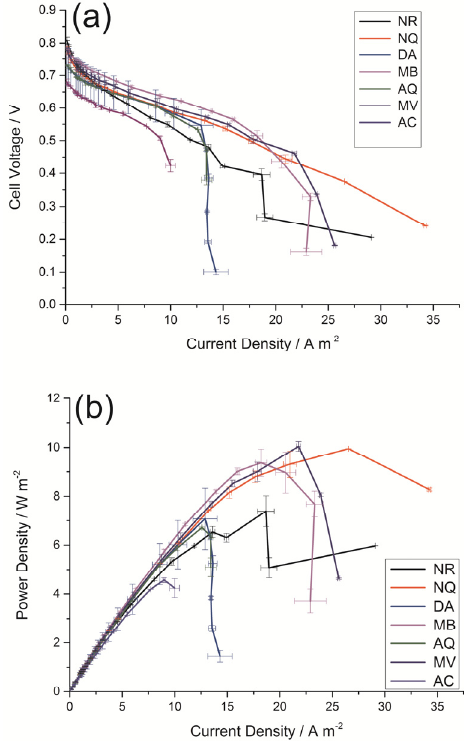
Figure 1. Polarization curves ( a ) and power density curves ( b ) of DGAFCs with AC anodes doped with different electron mediators under the condition of 1 M glucose and 3 M KOH.